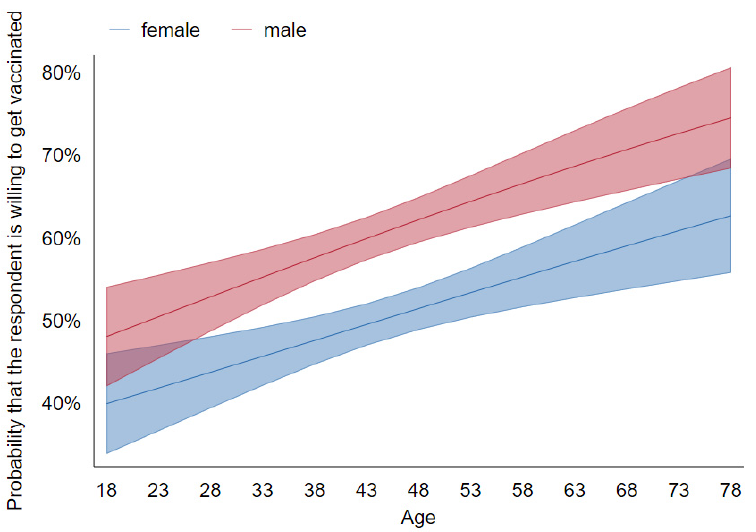
Figure 3. Predictive margins of sex and gender on vaccination decision with 95% CIs (Wave 2).